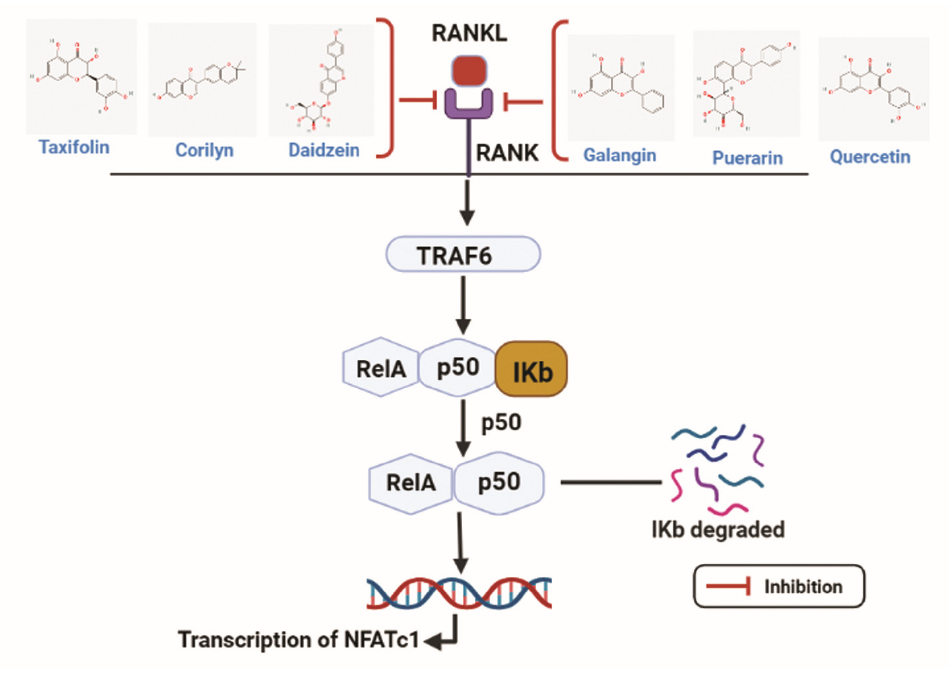
Figure 4. Taxifolin, corilyn, daidzin, galangix, puerarin, and quercetin acts as antagonists by hin- dering the transcription of the NFATc-1 gene by targeting RANKL. RANKL: Receptor activator of nuclear factor kappa-B ligand; RANK: Receptor activator of nuclear factor kappa-B; TRAF6: Tumor necrosis factor receptor associated factor 6; NFATc1: Nuclear factor of activated T cells 1. (Chemical structures source: PubChem (NCBI, NIH, USA; https://pubchem.ncbi.nlm.nih.gov/) accessed on 7 February 2023, Figures created with BioRender.com).